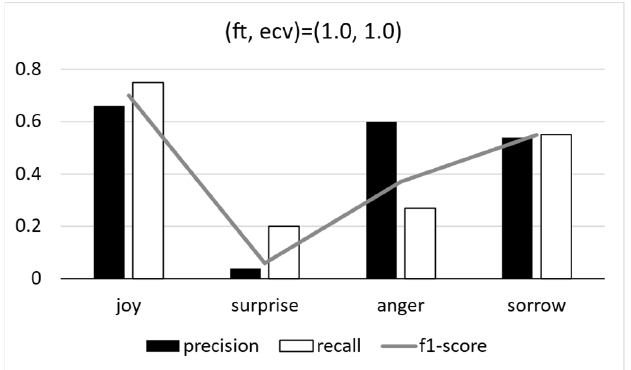
Figure 8. Result of baseline method; (ecv) = (1.0).